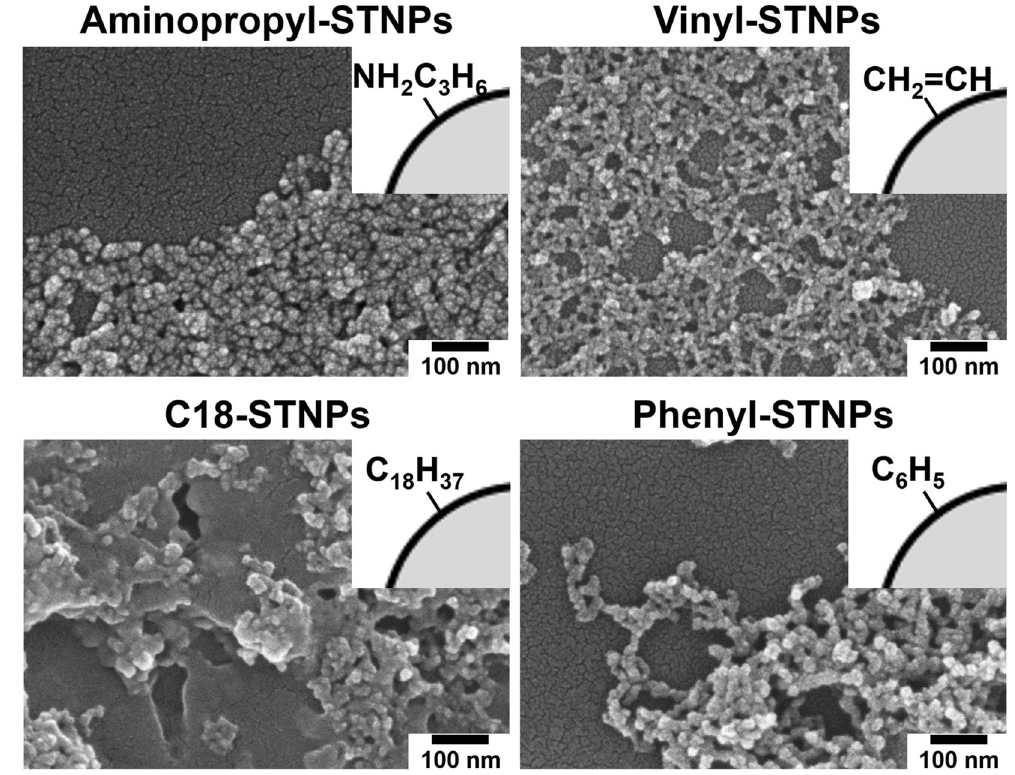
Figure 3. SEM images of four different types of NPs used in the present study: Aminopropyl-STNPs, Vinyl- STNPs, C18-STNPs, and Phenyl-STNPs.